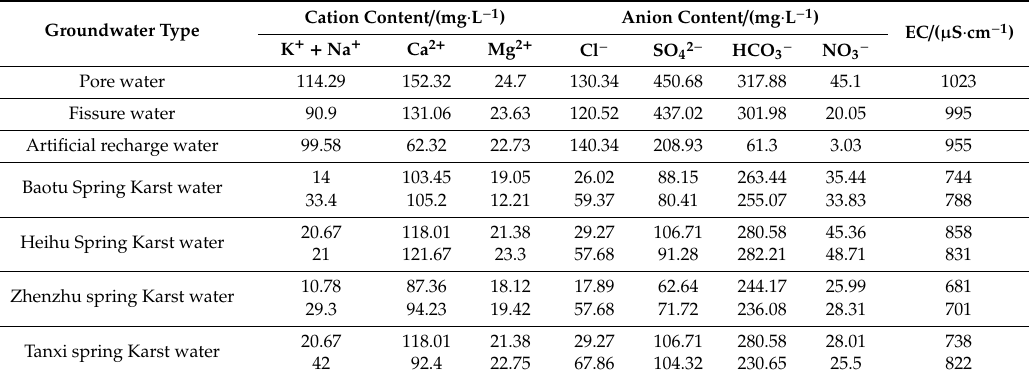
Table 5. Summary of water chemical characteristics.